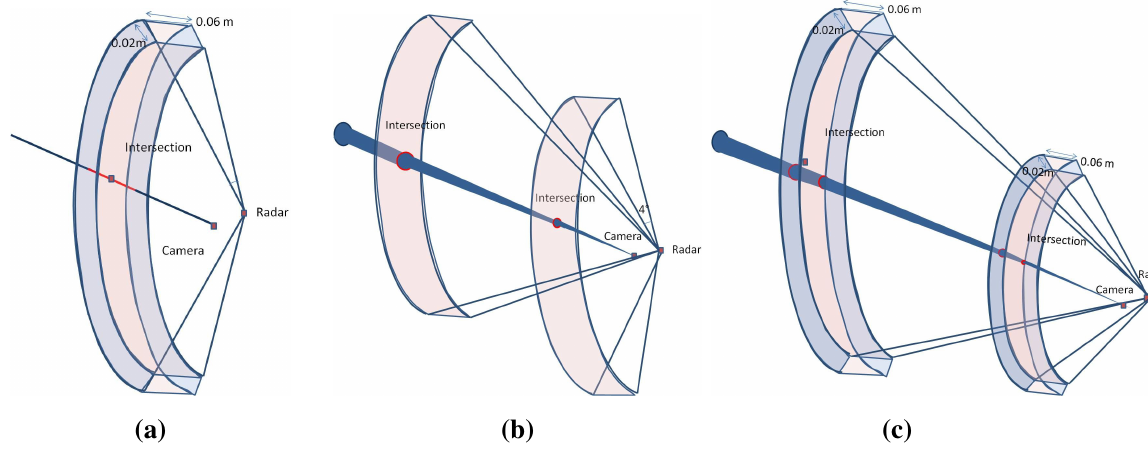
Figure 15. Illustration of the baseline effect on the reconstruction error. ( a ) Noise added only to radar data; ( b ) Noise added only to camera data; ( c ) Noise added to both camera and radar data.